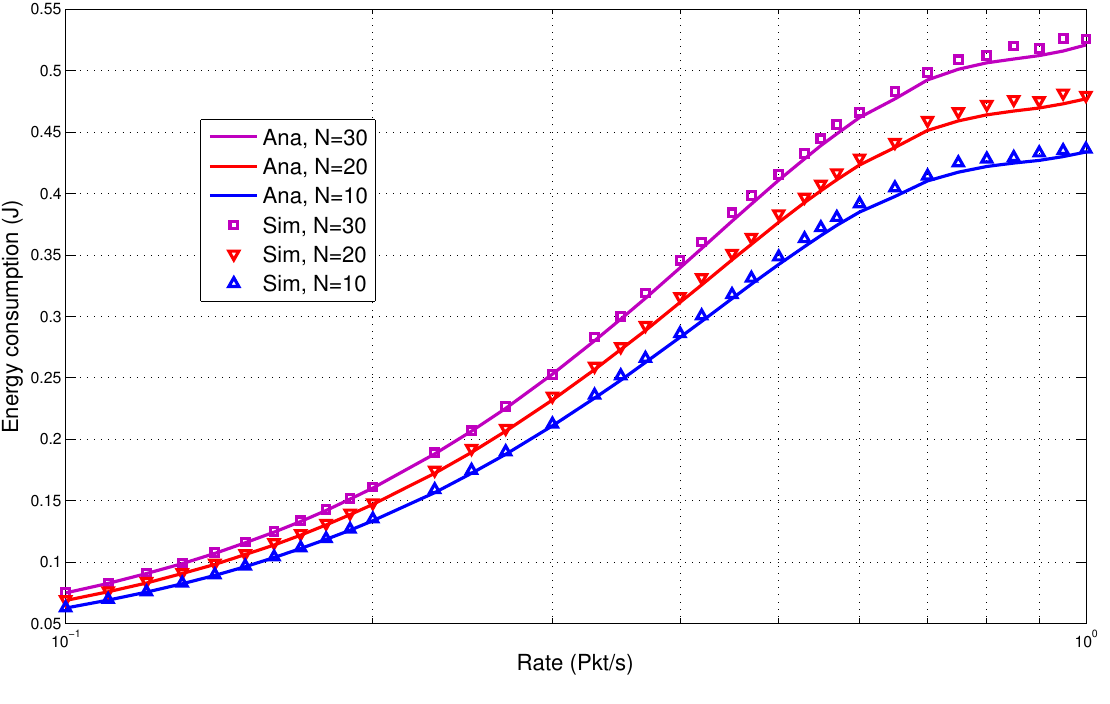
Figure 19. Combined traffic energy consumption.